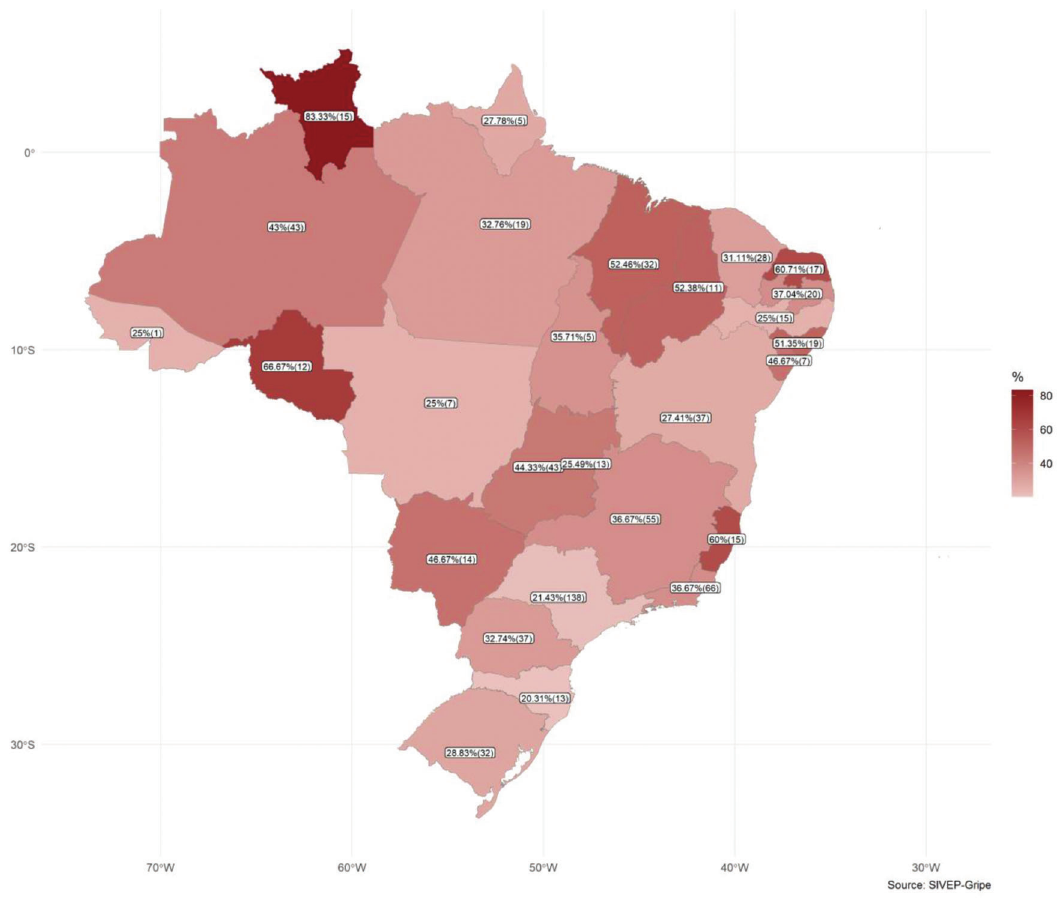
Figure 1 - Deaths of pregnant and postpartum women with confirmed coronavirus disease (COVID-19) in intensive care units.